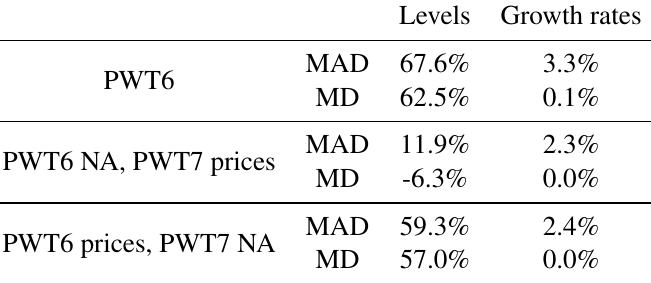
Table 2: Mean deviation and mean absolute deviation from